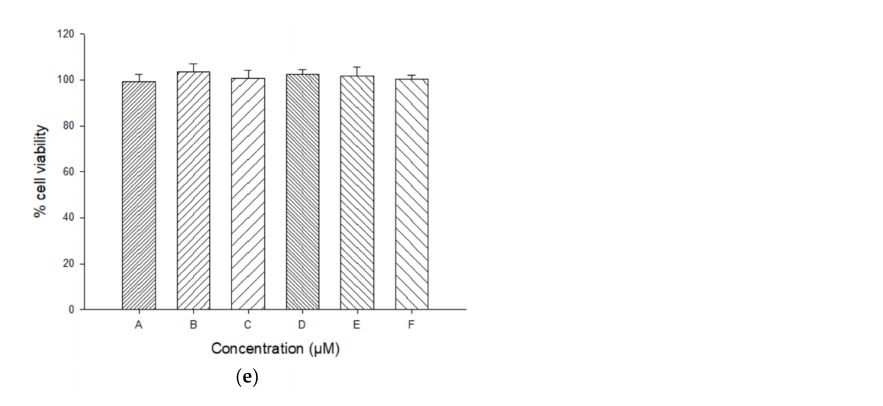
Figure 7. Cytotoxicity of the different samples: ( a ) Solution of CurEpi β CD complex (CurEpi β CD-Sol); ( b ) Optimized hydrogel without Epi β CD or Curcumin (Em-Gel); ( c ) Optimized hydrogel with Epi β CD only (Epi β CD-Gel); ( d ) Optimized hydrogel with Curcumin only (Cur-Gel); ( e ) Optimized CurEpi β CD-loaded hydrogel (CurEpi β CD-Gel).